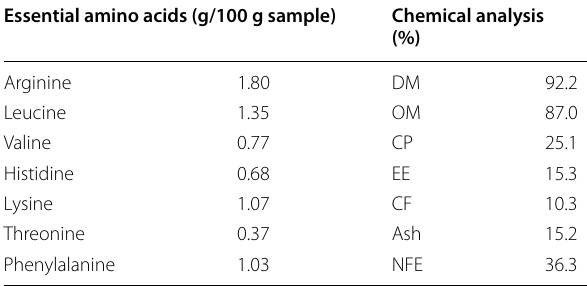
Table 2 chemical analysis and essential amino acids of